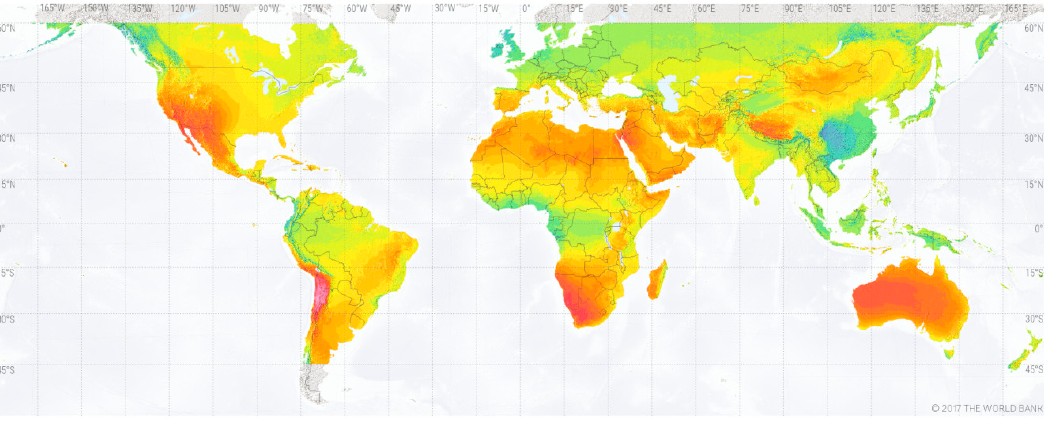
Figure 1. Direct normal irradiance